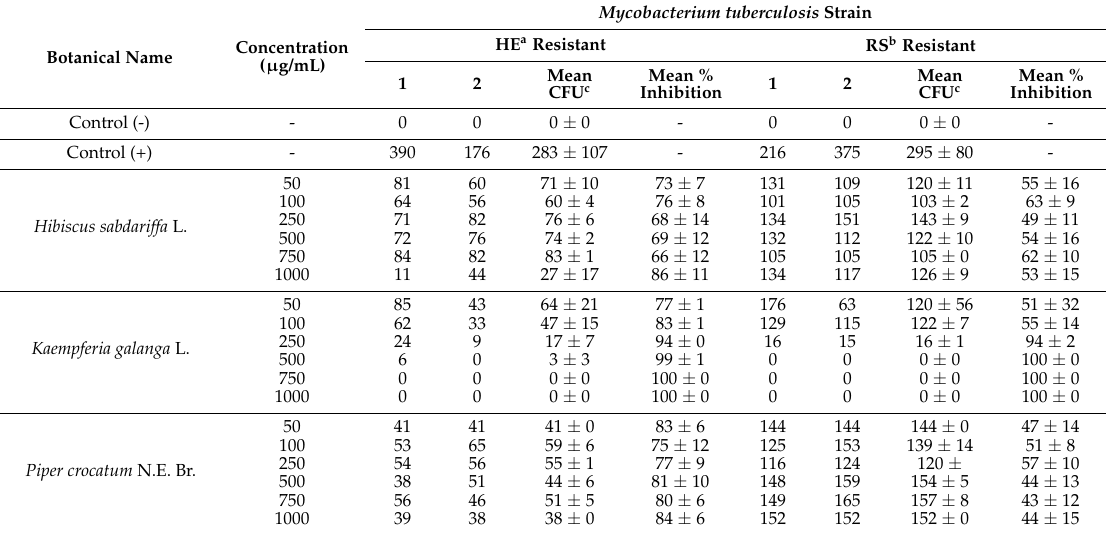
Table 3. Percent of inhibition of various extract concentrations against multi-drug resistant (MDR) Mycobacterium tuberculosis